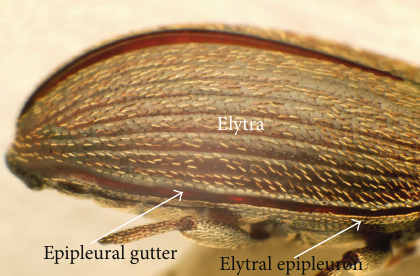
Figure 3: Epipleural gutter on the elytra of Mesomorphus